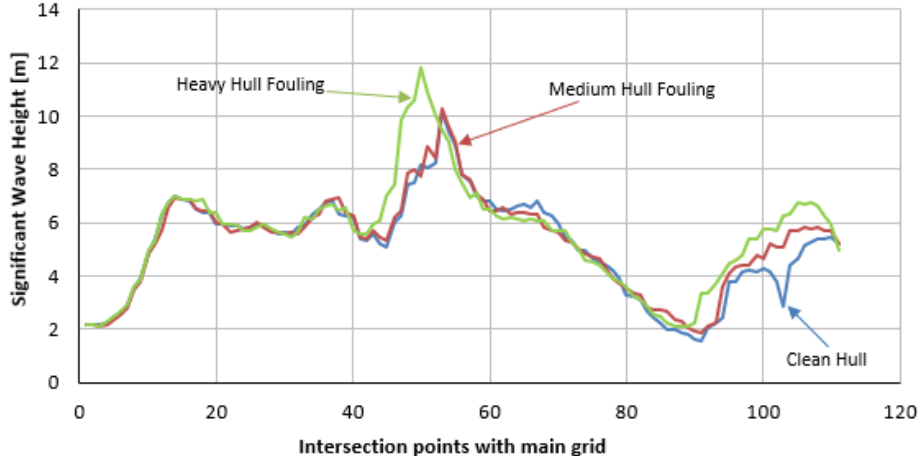
Figure 11. Prevailing significant wave height corresponding to optimum paths for different hull fouling conditions.